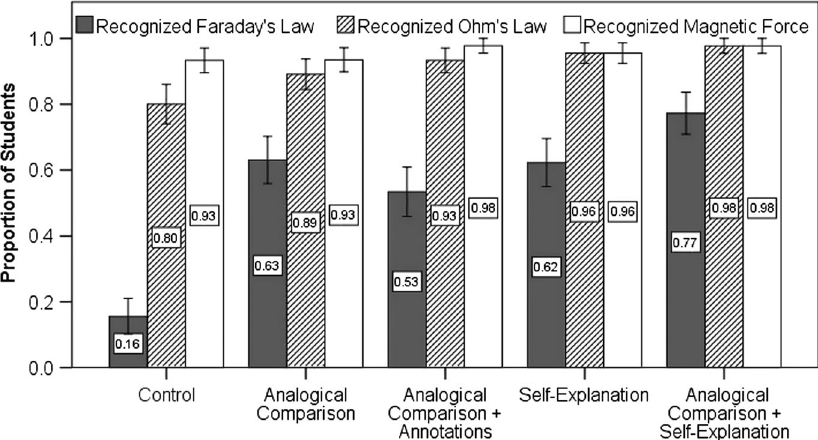
FIG. 8. Proportion of students in each condition demonstrating recognition of Faraday ’ s law, Ohm ’ s law, and magnetic force on the target synthesis problem. Error bars are standard errors.